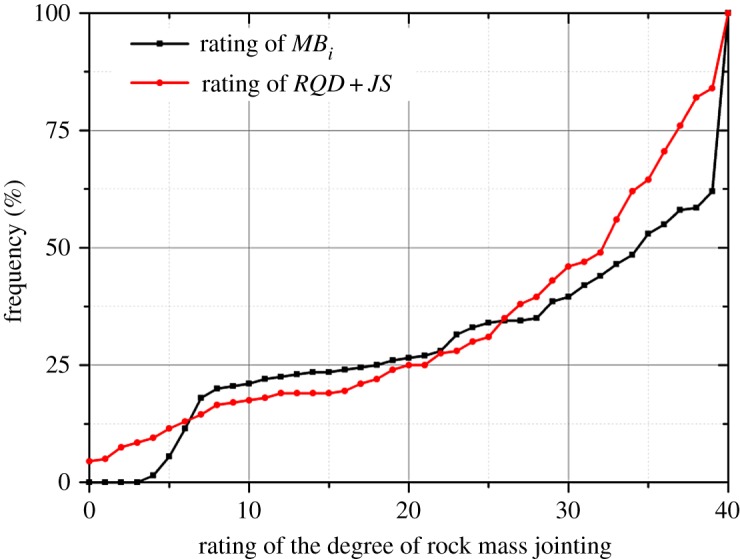
Comparison between RM and RRQD+JS (theoretical DFN models).